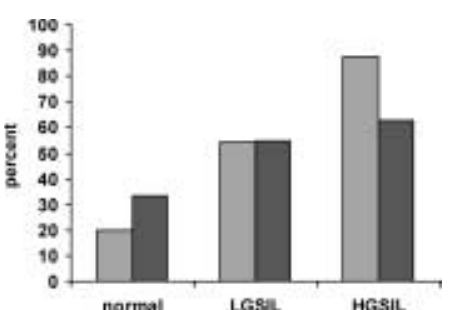
Fig. 1. HPV-positivity (blue) and telomerase activity (red) in normal cervical epithelium and squamous intraepithelial lesions, low grade (LGSIL), and high grade (HGSIL).